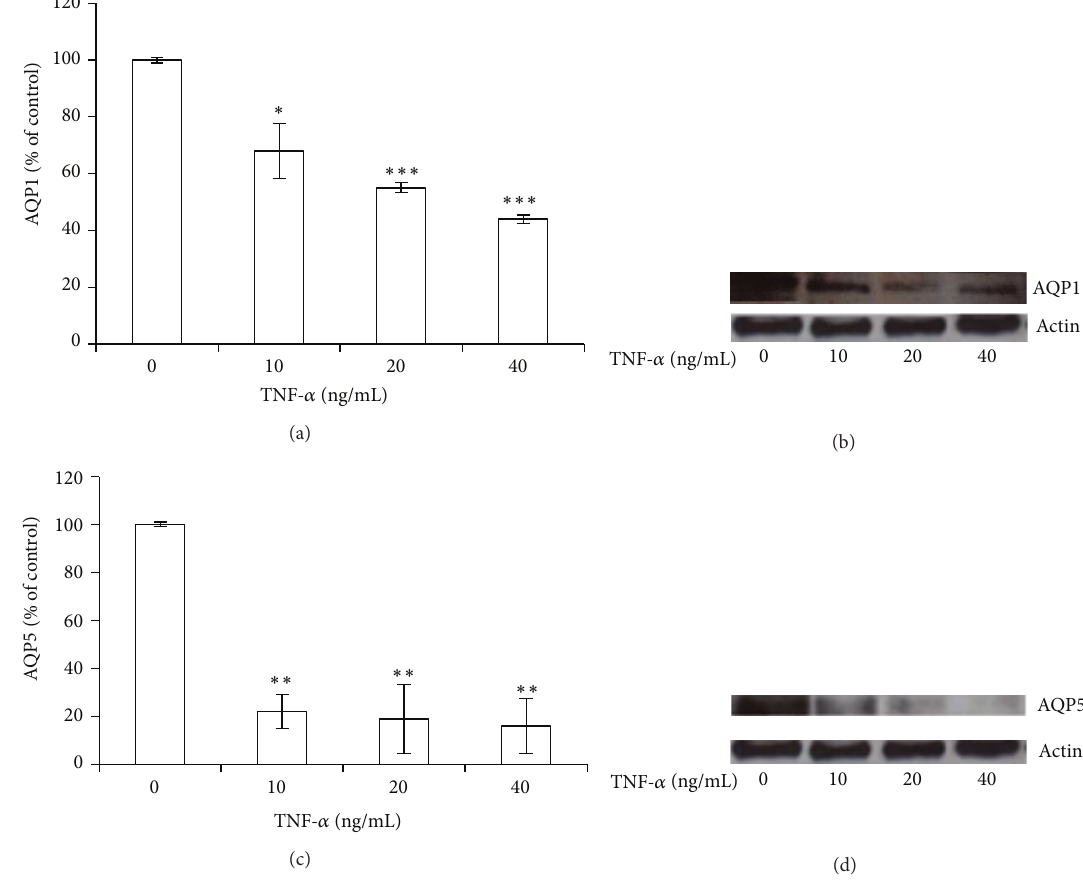
Figure 6: TNF- 𝛼 decreases AQP1 and AQP5 expression in BEAS 2B cells. BEAS-2B cells were treated with 10, 20, and 40ng/mL TNF- 𝛼 for 24 h. Gene expression of AQP1 ((a), (b)) and AQP5 ((c), (d)) at mRNA ((a), (c)) and protein ((b), (d)) level. Western blots were obtained by using the specific rabbit polyclonal Abs. The blots were stripped of the bound Ab and reprobed with mouse anti- 𝛽 -actin, to confirm equal loading. Western blots are representative of three separate experiments. All histograms indicate means ± SD of three different cultures each one tested in quadruplicate and expressed as percentage of control ( ∗ 𝑃 < 0.01 , ∗∗ 𝑃 < 0.001 , and ∗∗∗ 𝑃 < 0.0001 versus untreated